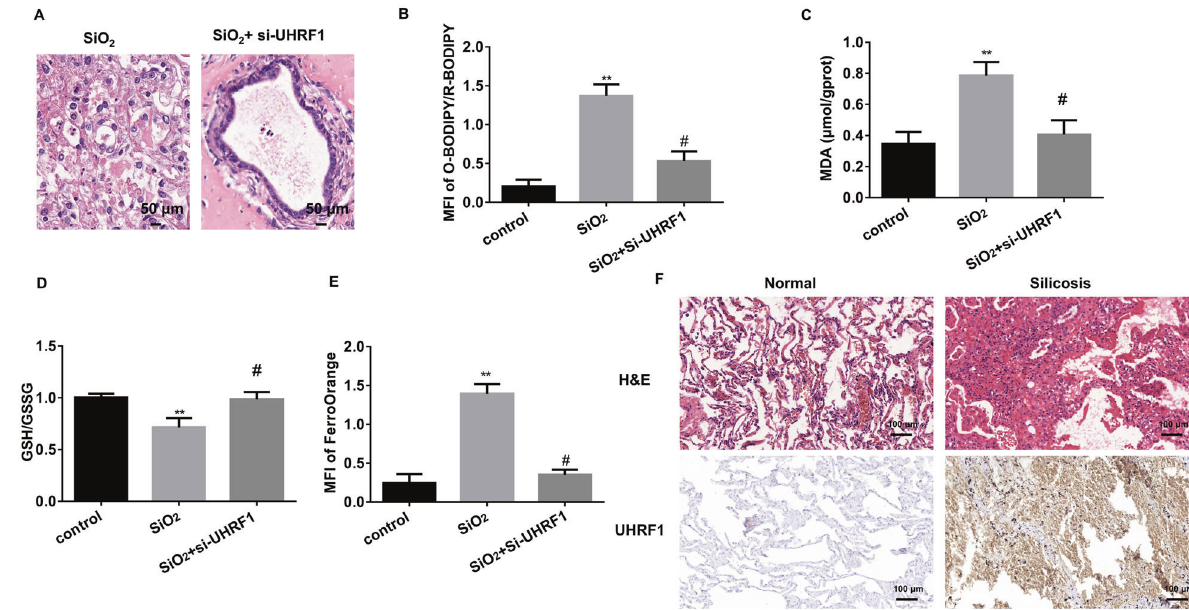
Fig. 7 AEC2 3D model con fi rms UHRF1-regulated ferroptosis in PF. A Representative HE staining of primary AEC2 cell 3D culture treated by SiO 2 with or without UHRF1 siRNA for 14 days. B quanti fi cation of C11-BODIPY fl uorescence in primary AEC2 organoid cells (** P < 0.01 versus control group, # P < 0.01 versus SiO 2 -treated group). C MDA concentration in cell lysates from primary AEC2 organoid (** P < 0.01 versus control group, # P < 0.01 versus SiO 2 -treated group). D GSH/GSSG ratio of primary AEC2 organoid cells (** P < 0.01 versus control group, # P < 0.01 versus SiO 2 -treated group). E Intracellular Fe 2 + fl uorescence intensity was quanti fi ed in both primary AEC2 organoid cells (** P < 0.01 versus control group, # P < 0.01 versus SiO 2 -treated group; right panel). F Representative HE and UHRF1 IHC staining in normal and silicosis patient lung tissues (scale bars, 100